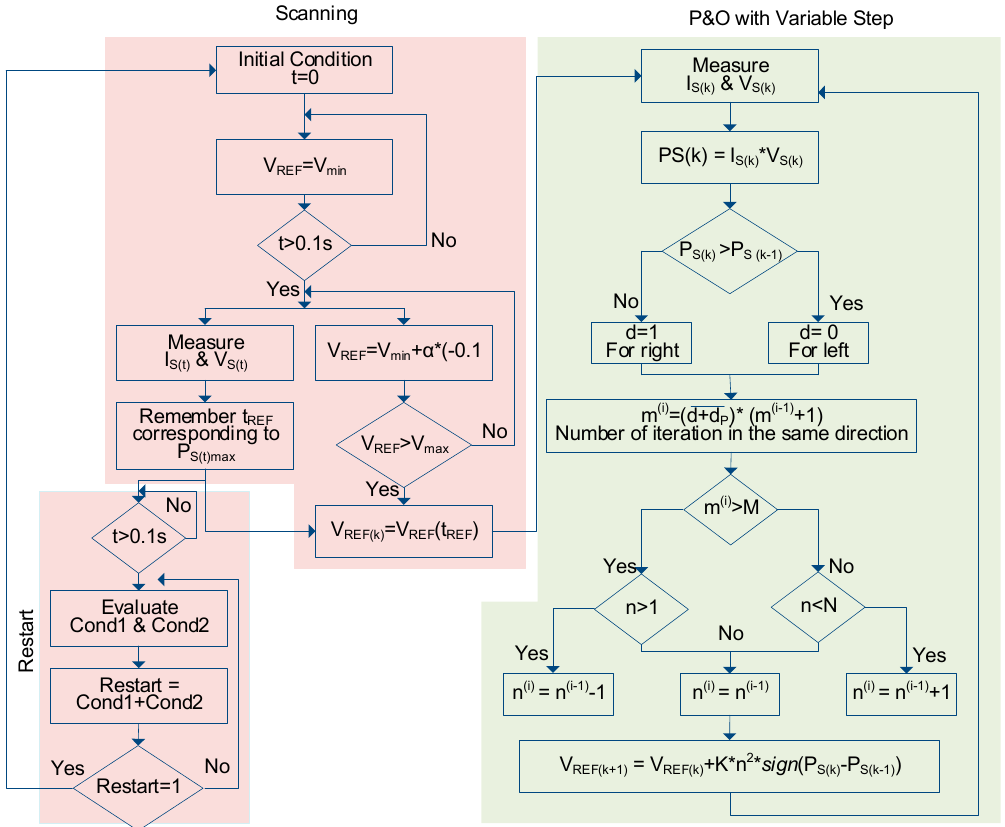
Figure 11. Flow chart of the power load characteristic with variable step size [47].